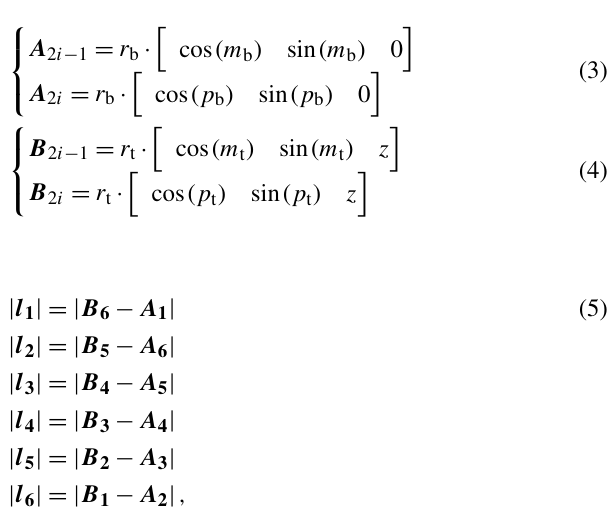
Figure 2. Diagram of 6-DOF parallel